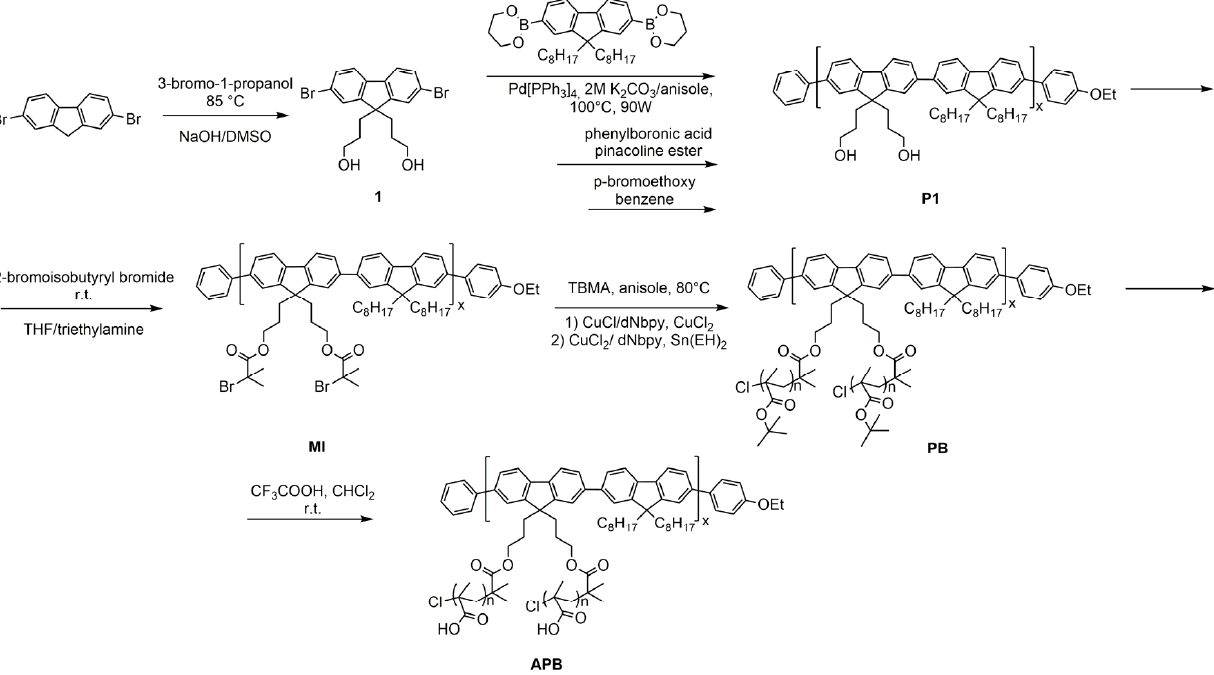
Table 2. Conditions of syntheses and characteristics of PBs and